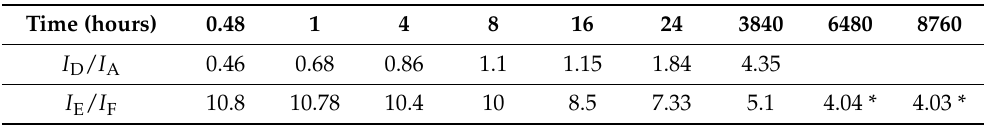
Table 5. Values of the IR band intensity ratio for samples obtained at different times. Values of the I E and I F heights were normalized to the corresponding ν 3 band